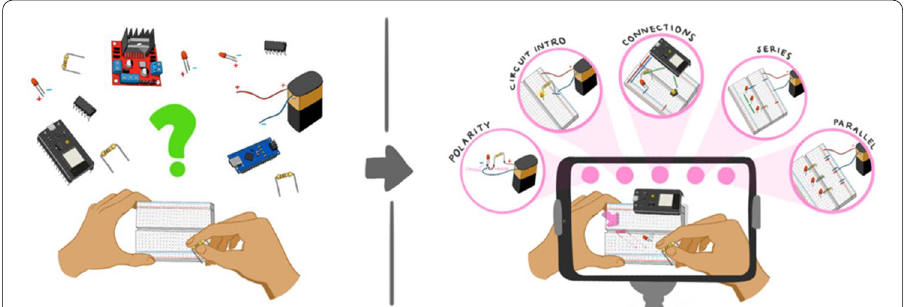
Fig. 1 Overview of our model to provide a user with basic mastery of electrical circuitry. (Left) Electrical circuitry as a wide body of knowledge with multiple concepts and electrical components, even at the basic level. (Right) We break down electrical circuitry into fundamentals or microskills–smallest segmentation of this knowledge–which are delivered by AR (phone-based), allow the user to perform a variety of tasks that are conducive to the acquisition of the